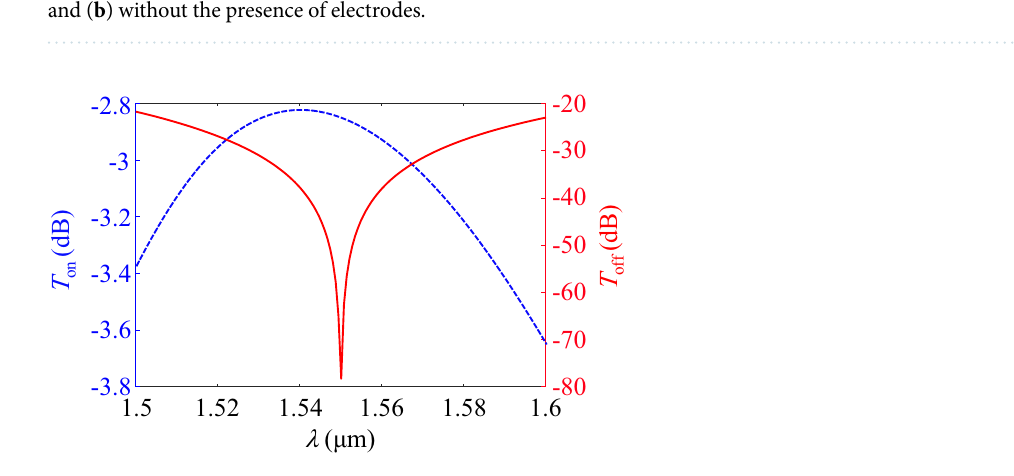
Figure 7. The calculated electric field profiles and effective indices of guided modes for the waveguide ( a ) with and ( b ) without the presence of electrodes.